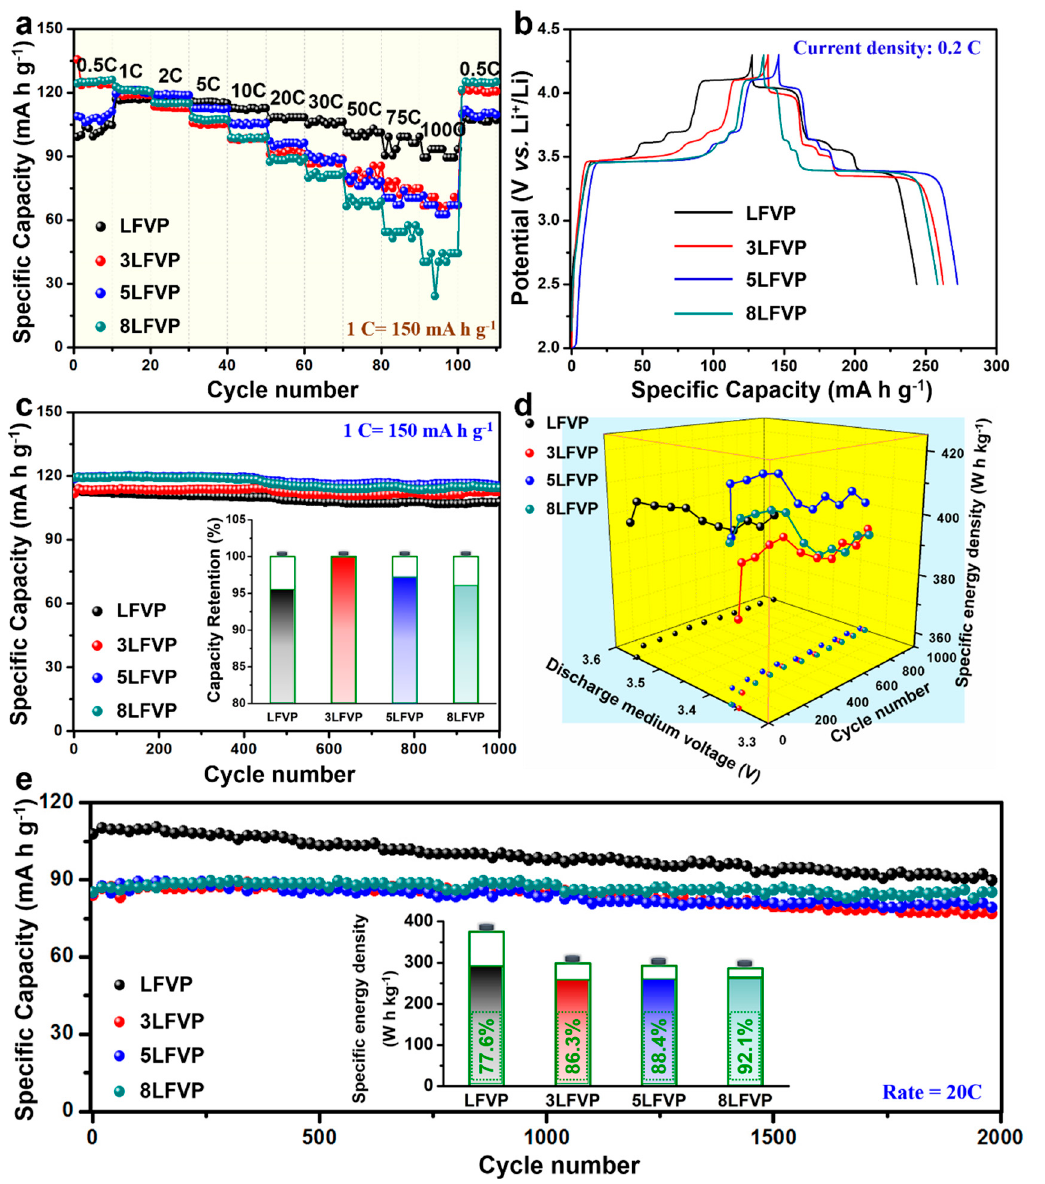
Figure 3. The comparison of xLFP · yLVP electrodes in terms of Li-ion storage capability estimated in the range 2.5–4.3 V; ( a ) rate performance; ( b ) the galvanostatic charge–discharge curves; ( c ) cycling performance at 1 C; ( d ) comparison of the material energy density; ( e ) cycling performance at the high rate of 20 C.